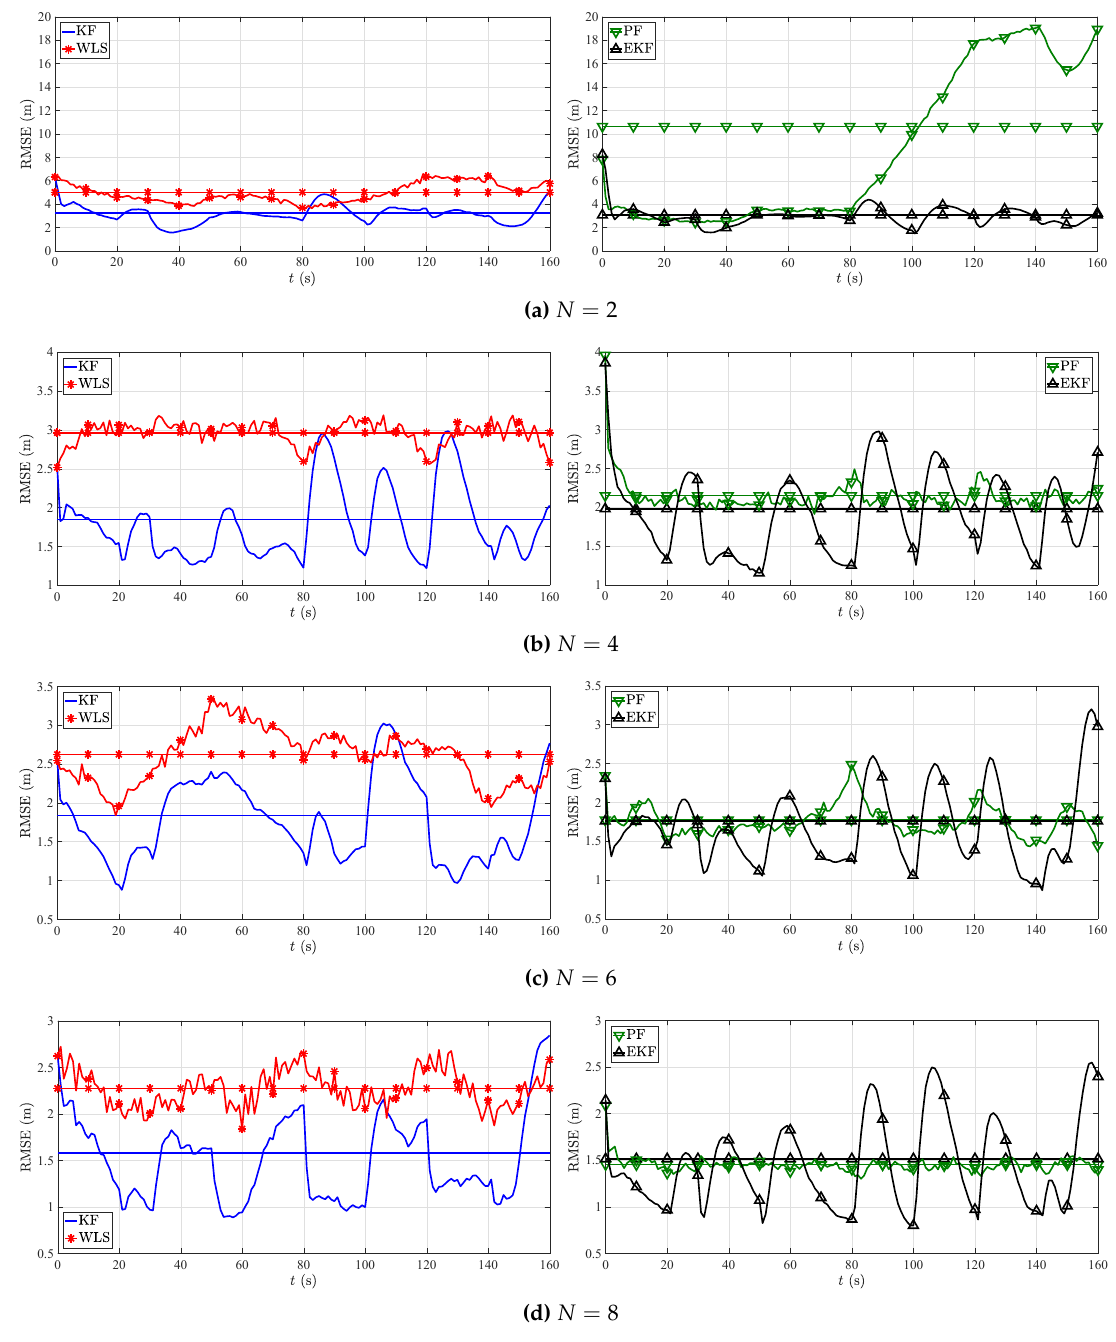
Figure 5. RMSE versus t (s) for different N , when |L NLOS | = N , σ i = 3 (dB, m), bias max = 5 (dB, m), bias i ∼ U [ 0,bias max ] , B = 30